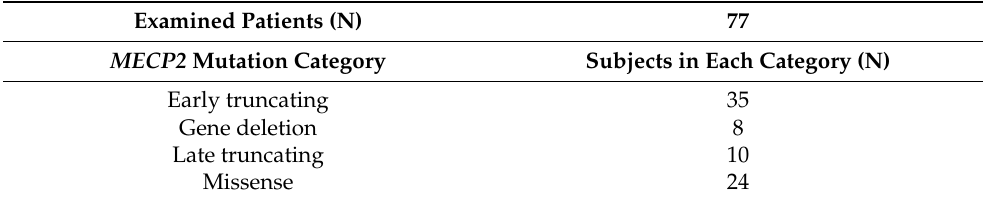
Table 2. MECP2 mutations of the examined RTT population.